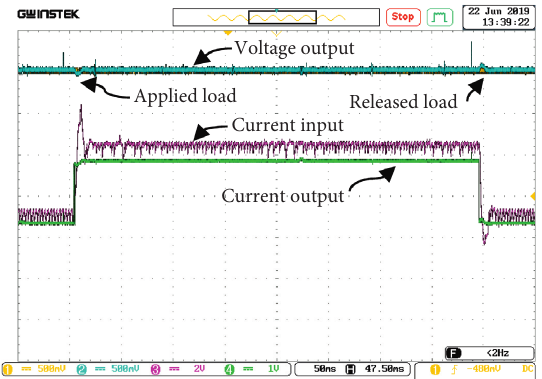
Figure 25: Result of voltage response and current using a PI controller with GA search.